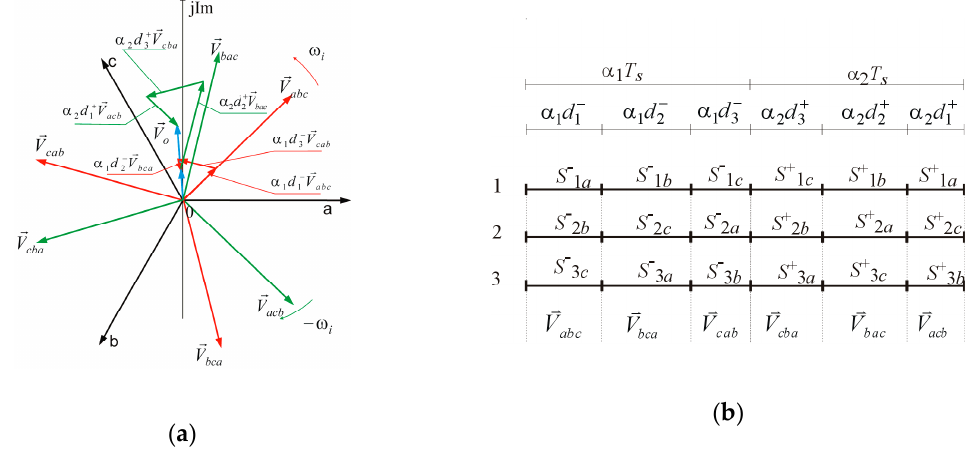
Figure 2. Synthesis of output voltage during T s switching period: ( a ) Summation of the input voltage rotating voltage space vectors; ( b ) switch duty cycles.